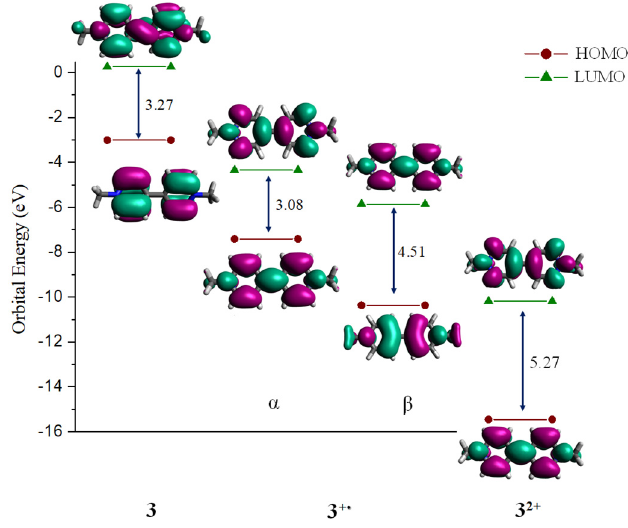
Figure 4. Frontiers molecular orbital values and orbital shape for the different oxidation states of